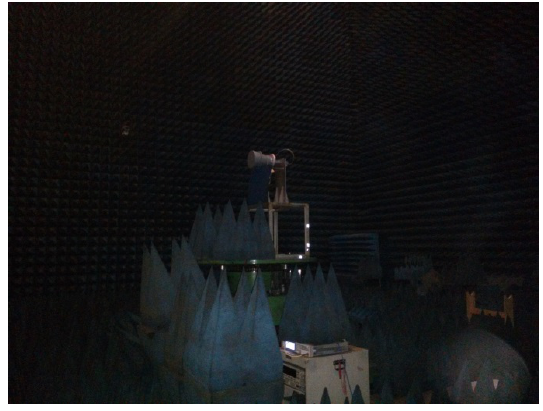
Figure 4. Outer view of the antenna under testing in the anechoic chamber.